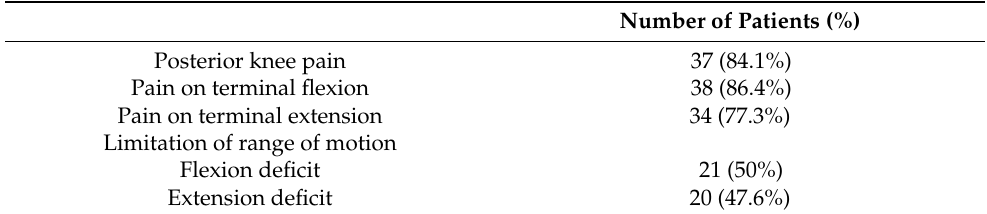
Table 1. Clinical findings of mucoid degeneration of the anterior cruciate ligament (MD-ACL) ( n =